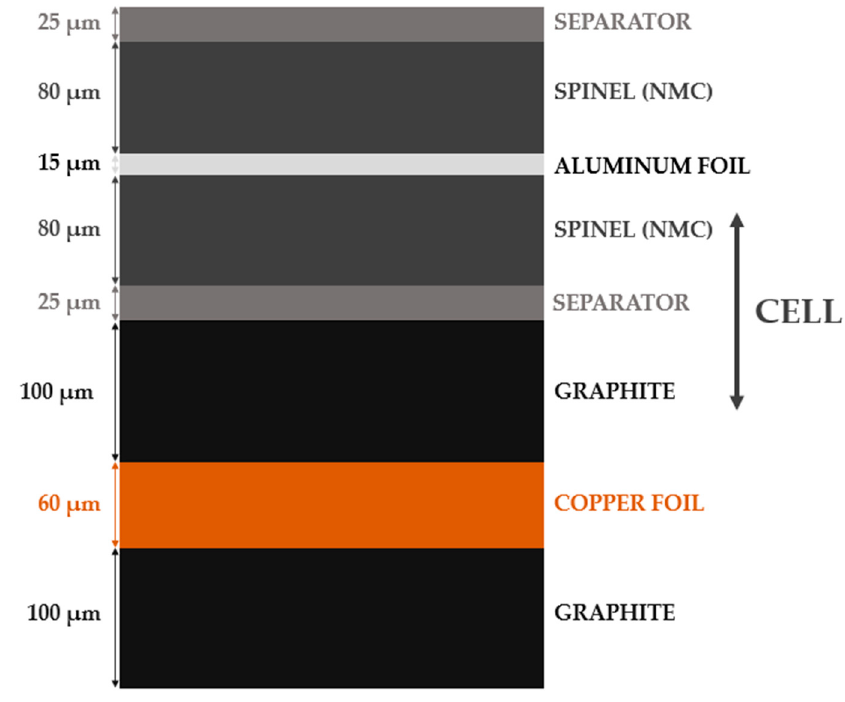
Figure 3. Scheme of the analyzed NMC battery cell structure.